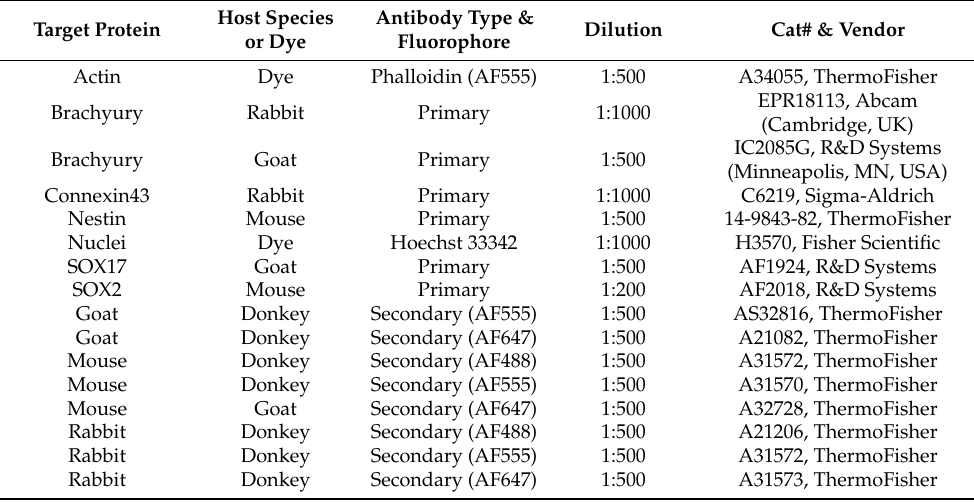
Table 1. Primary and secondary antibodies and dyes used in immunofluorescence.